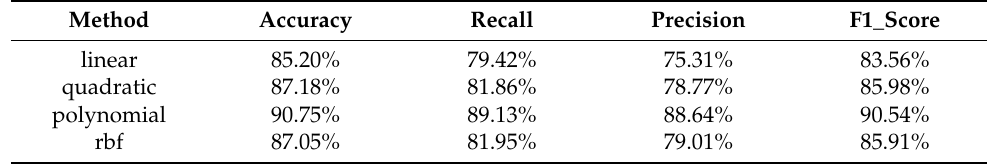
Table 5. Training results using ACO as a feature selection technique on balanced